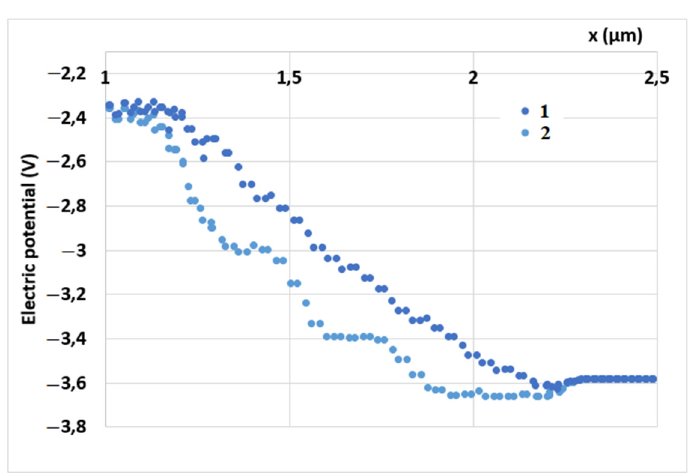
Figure 6. Electric potential distribution. Different number of surface charge Q s segments. U ct = 0.5 V, U an = 1 V, U g = 3 V. Cutline Y = 0.65 µ m, GaAs, p -type, p = 10 12 cm − 3 . Surface charge density ρ = 10 − 3 C · m − 2 . Uniform charged film ( 1 ) was divided for three islands ( 2 ), as shown in Figure 2 above.